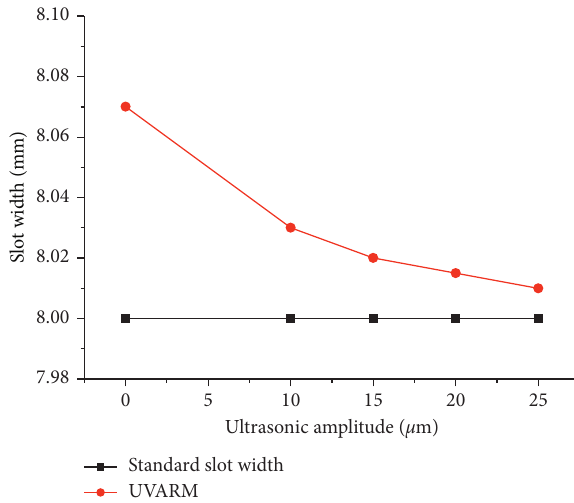
Figure 26: Dimensional accuracy of grooves under different am- plitude